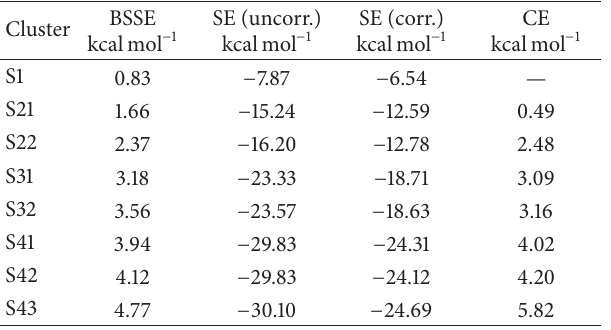
Table 2: BSSE, stabilization energy corrected with ZPE, uncor- rected stabilization energy, and cooperative effect (CE) calculated at B3LYP/6-311++G(d,p).